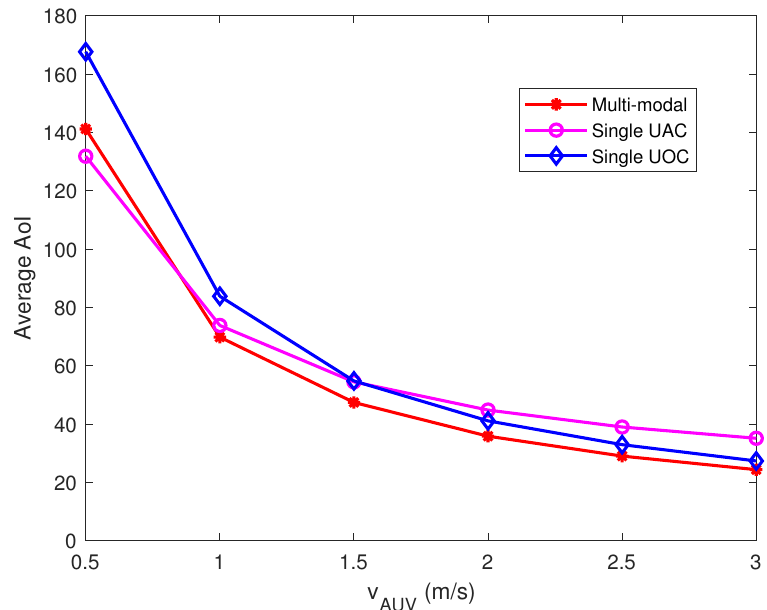
Figure 4. Effect of AUV velocity on AoI of collected